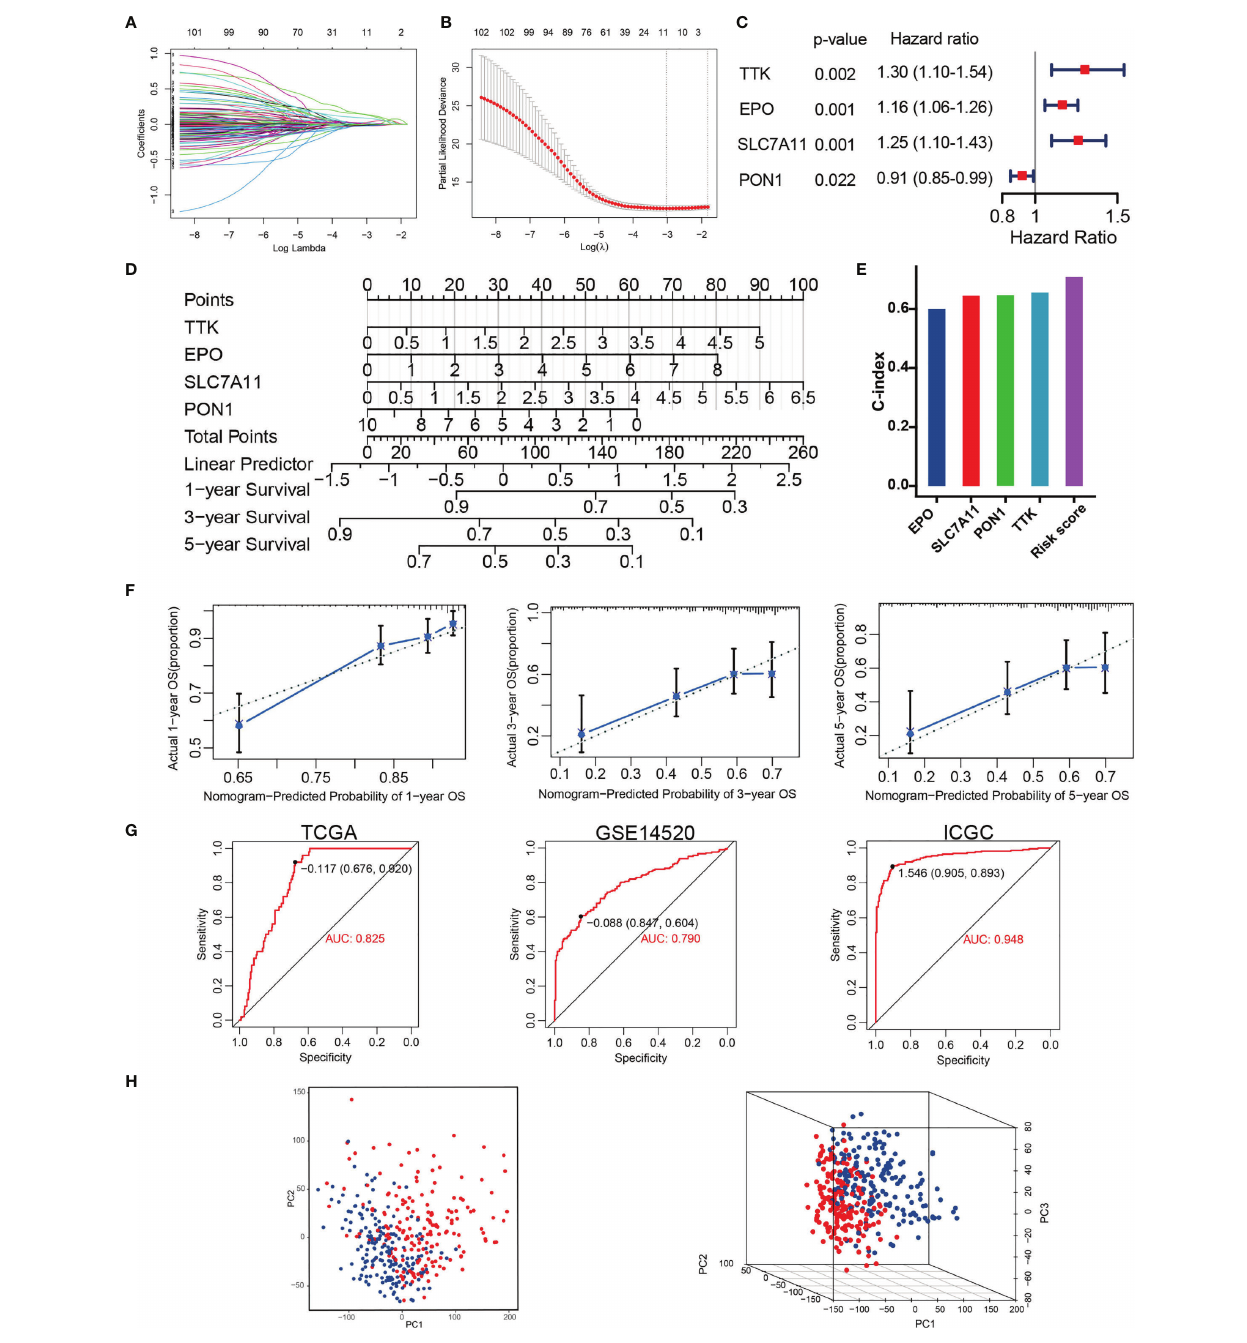
FIGURE 3 | Construction of TACE refractoriness – related prognostic score (TRP score). (A, B) LASSO regression analysis of the prognostic TRGs. (C) The multivariate Cox regression result. (D) Nomogram predicting the probability of patient mortality at 1, 3 or 5 year OS based on four prognostic signatures. (E) C-index of various variables. (F) Calibration curves of the nomogram. (G) ROC curves analysis of the nomogram in TCGA, GSE14520 and ICGC. (H) PCA plot showing distribution in the high- and low-risk